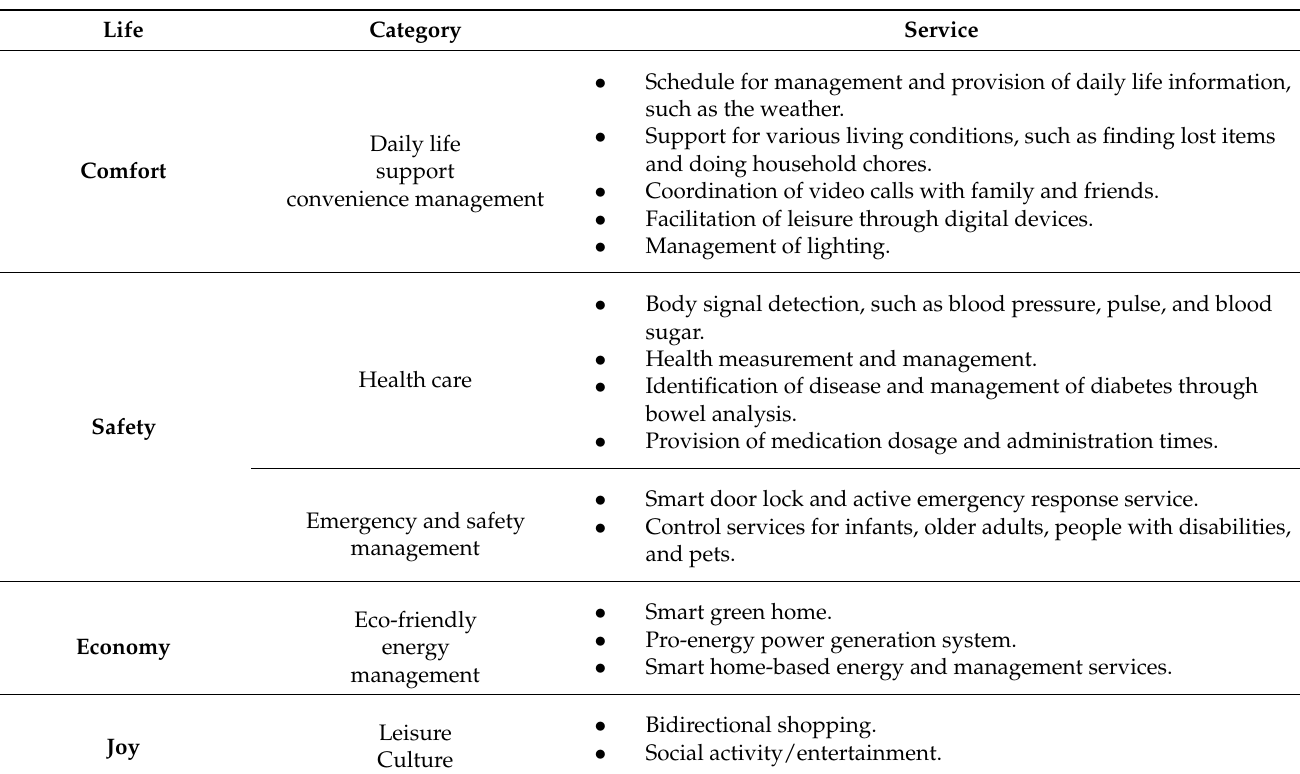
Table 2. Smart home value classification [9].